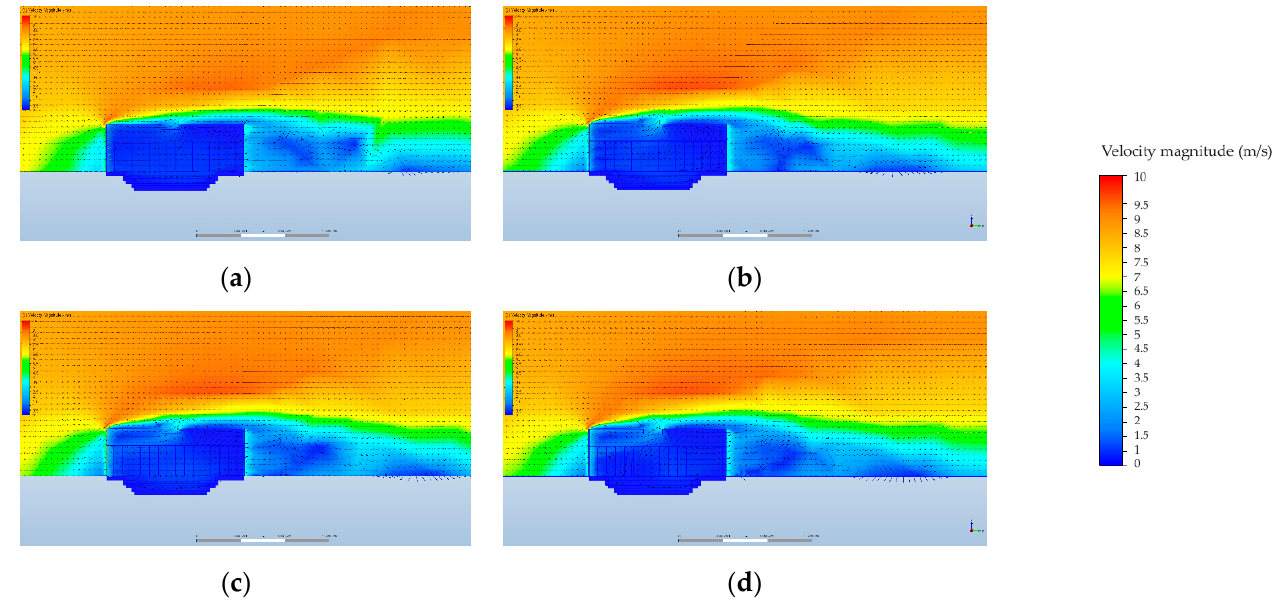
Figure 10. Airflow velocity and direction inside and nearby the plank house, whose smoke hole is opened ( a ) 1 cm gap; ( b ) 2 cm gap; ( c ) 3 cm gap; ( d ) 4 cm gap (Autodesk CFD ®